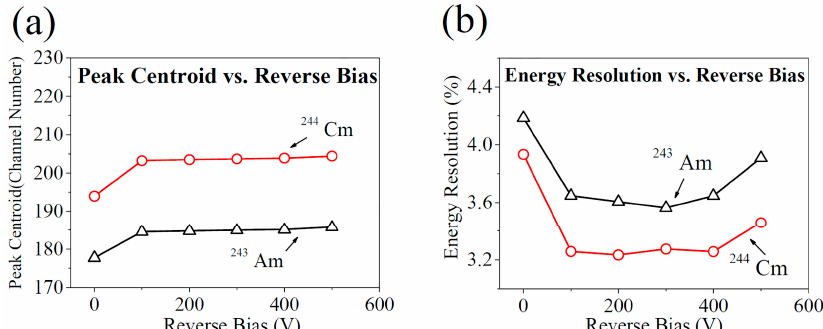
Figure 5. Characteristics of the pulse height spectra of the 4H-SiC detector in response to the alpha particles emitted from the 243 Am (black open triangle) and 244 Cm (red open circle) source ( a ) channel number of alpha peak centroid as a function of applied reverse bias voltages ranging from 0 to 500 V; ( b ) energy resolution as a function of reverse bias voltage.